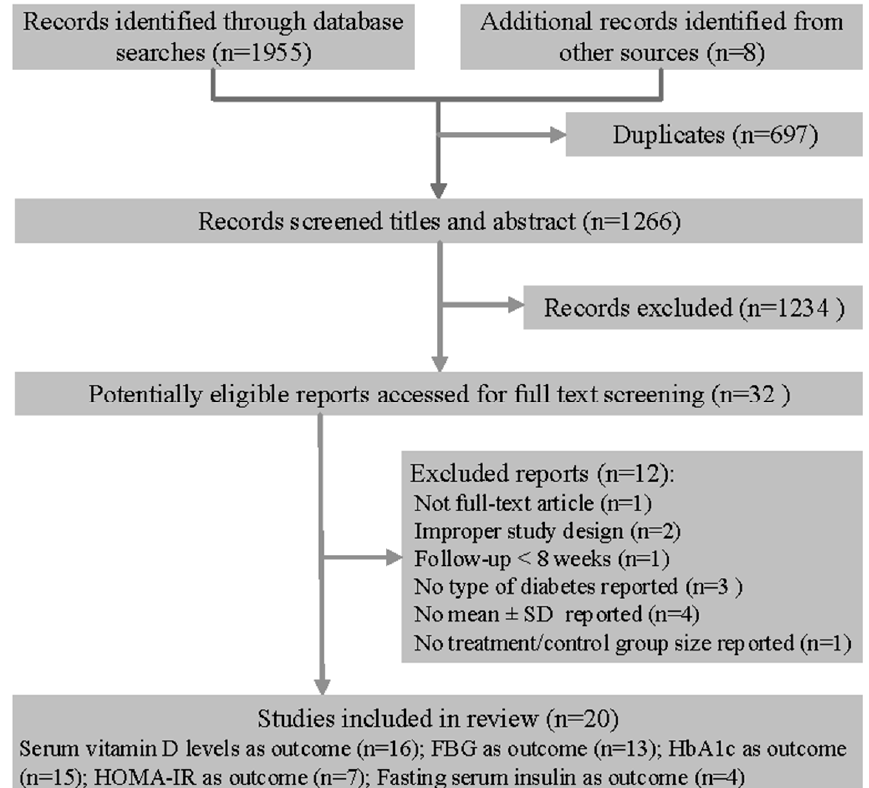
Figure 1. Flow diagram of search and selection of studies.